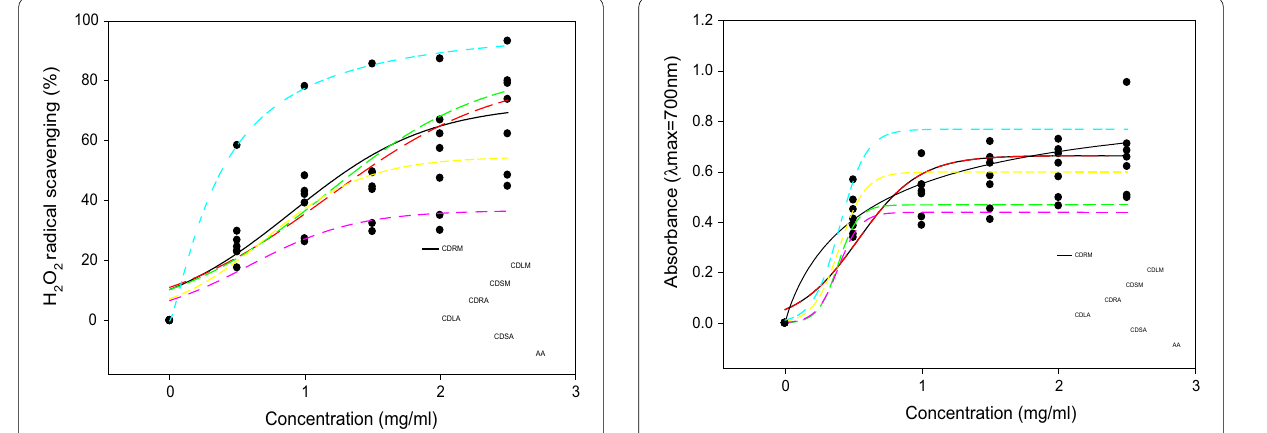
Fig. 4 Hydrogen peroxide radical scavenging activities of crude aqueous and methanol extracts of leaves, stem and roots of C. dependens and ascorbic acid standard